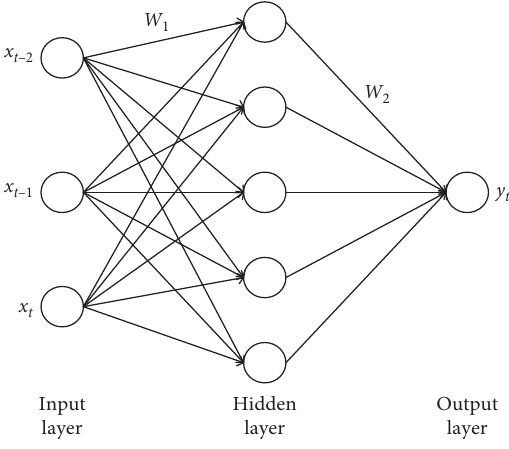
Figure 6: The prediction frame of the BP model.